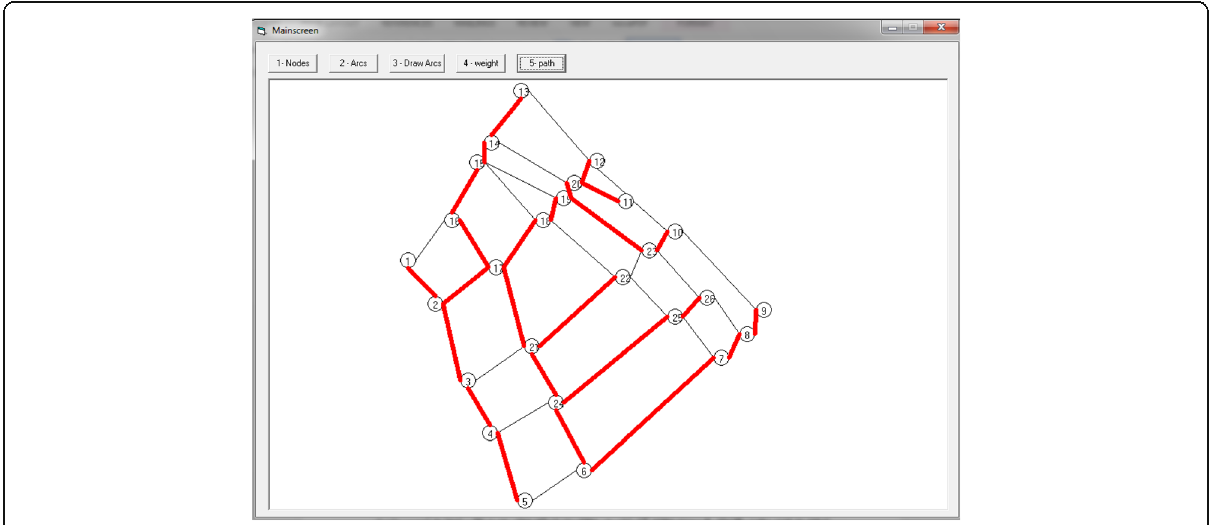
Fig. 21 The Results Derived from Implementing the Model of Population Density Index on the Sample Data using